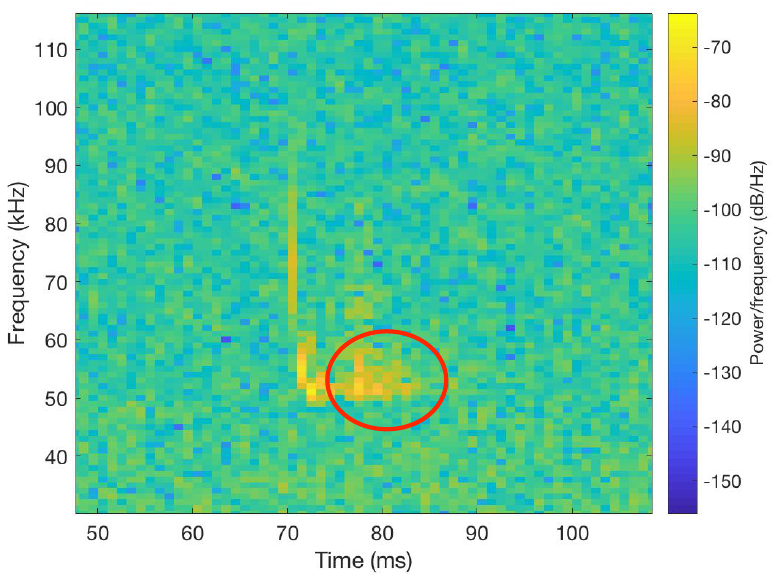
Figure 3. Echo produced by the bounce of the signal to the